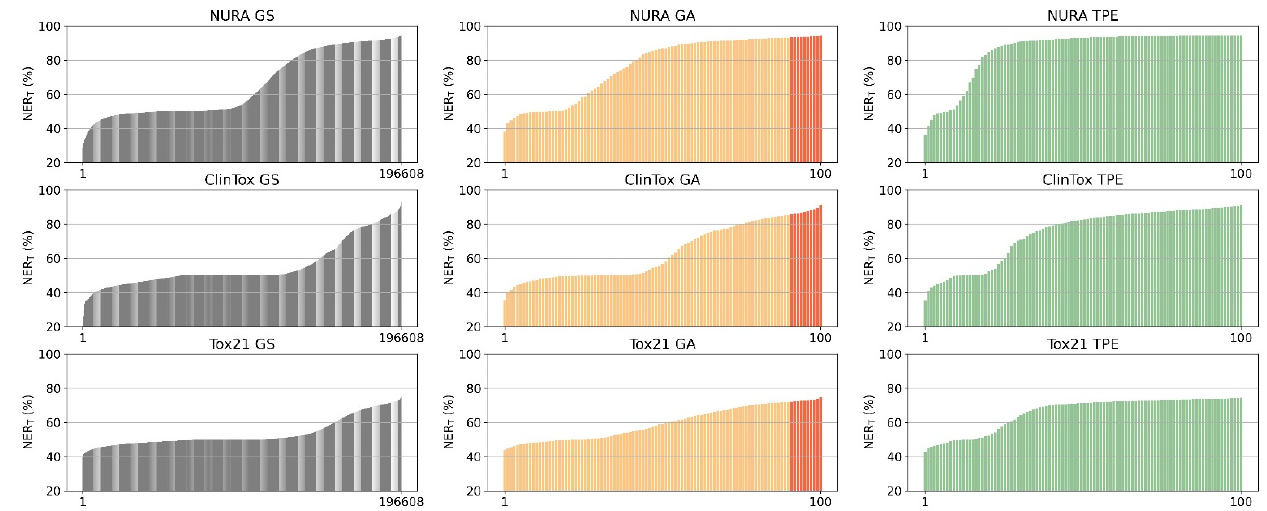
Figure 1. Ordered distribution of the overall non-error rate (3-fold cross-validation) of the architectures found by the optimization methods (columns, grid search, GS, genetic algorithm, GA, and tree-structured Parzen estimator, TPE) for NURA, ClinTox, and Tox21 datasets (rows). For GA, red and orange bars represent the performance of the final population (10 chromosomes) and all the other tested architectures, respectively. Table 1. Results in terms of overall non-error rate (NER T ) considering grid search (GS), genetic algorithms (GA), random search (RS), and tree-structured Parzen estimator (TPE) as optimization strategies in 3-fold cross validation. The computa- tional time for 3-fold cross-validation is also reported in hours (h). Mean and confidence interval among 10 replicas are reported for GA, RS, and TPE